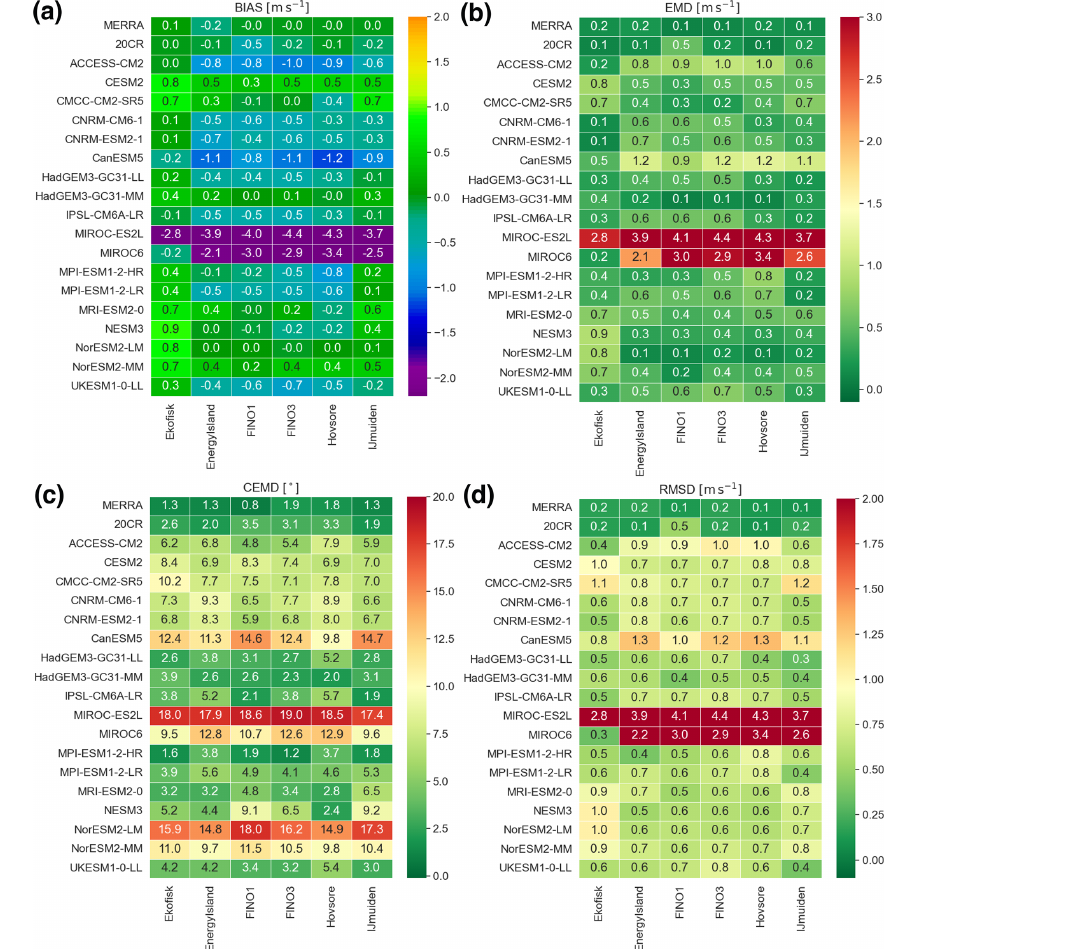
Figure 6. Evaluation metrics of the 100m wind climatologies for the reanalysis and CMIP6 models, i.e. (a) BIAS (ms − 1 ), (b) EMD (ms − 1 ) for the simulated wind speed, (c) CEMD ( ◦ ) for simulated wind direction, and (d) RMSD of the mean annual cycle (ms − 1 ), at the six locations in the North Sea for the full historical period (1980–2014). The wind climatologies are evaluated against that of the